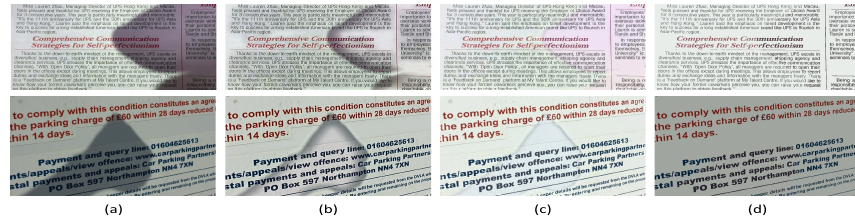
Figure 9. The visual comparisons of some state-of-the-art methods for text shadow removal. ( a ) the input images, ( b ) the results of [11], ( c ) the results of [24], ( d ) our